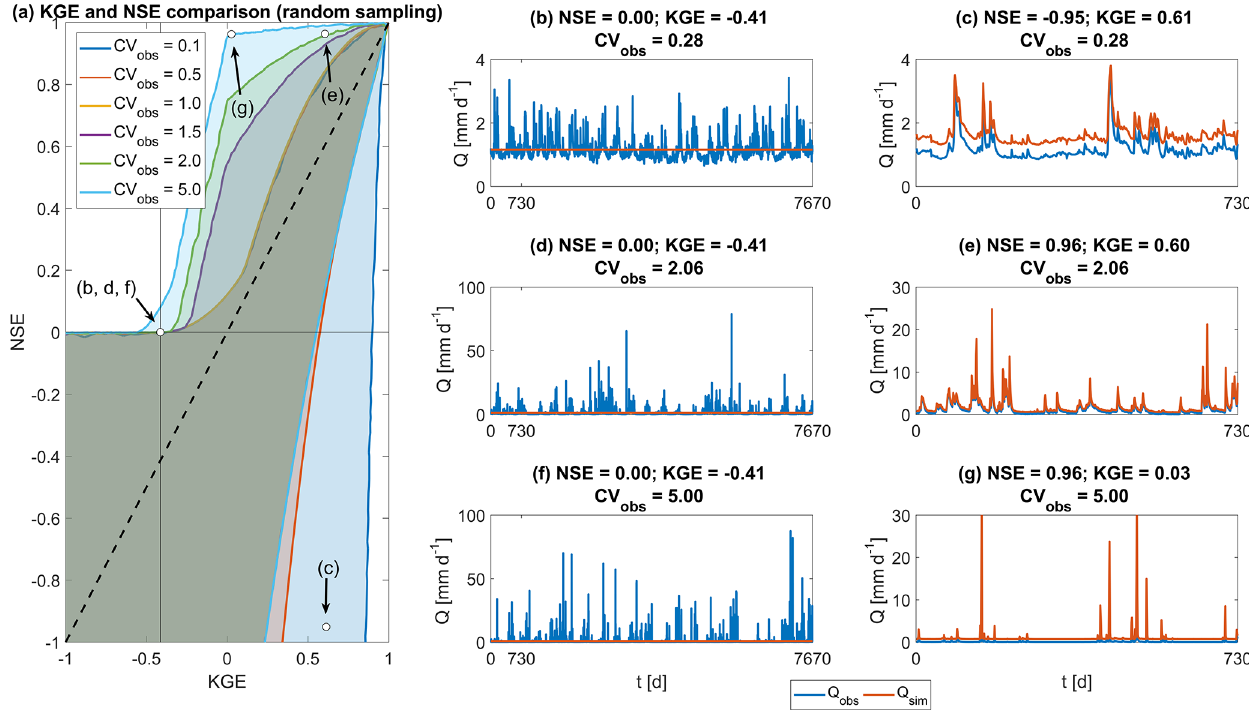
Figure 1. Overview of the relationship between NSE and KGE. (a) Comparison of KGE and NSE values based on random sampling of the r , a and b components used in KGE and NSE, using six different values for the coefficient of variation of observations (see Appendix −√ for method and separate plots of each plane). Internal axes are drawn at KGE = 1 2 and NSE = 0. The dashed diagonal is the 1:1 line. Locations of panels (b) – (g) indicated in brackets. (b, d, f) Simulated flow Q sim is created from the mean of Q obs . (c) Q sim is created as Q obs + 0 . 45mmd − 1 on every time step, increasing the bias of observations. (e) Q sim is created as Q obs + 0 . 5mmd − 1 on every time step. (g) Q sim is created as Q obs + 0 . 7mmd − 1 on every time step. The y axis is capped at 30mmd − 1 to better visualize the difference between observations and synthetic simulations. (b) – (g) Flow observations are taken from the CAMELS data set (Addor et al., 2017a),